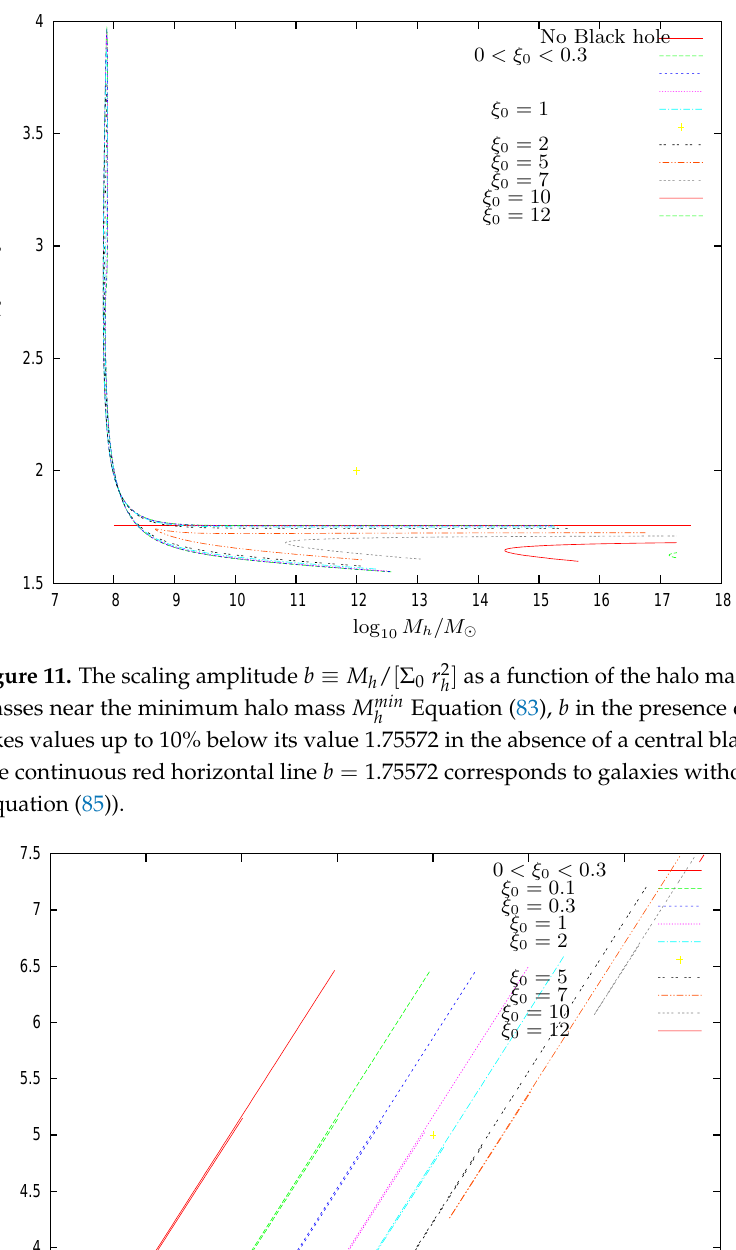
log 10 r/r h FIG. 13: The logarithm of the local pressure log 10 P ( r ) vs. log 10 ( r/r h ) for the three galaxy solutions with central SMBH. Notice the huge values of P ( r ) in the quantum (high density) region r < r A and its sharp decrease entering the classical (dilute) region r > r A .